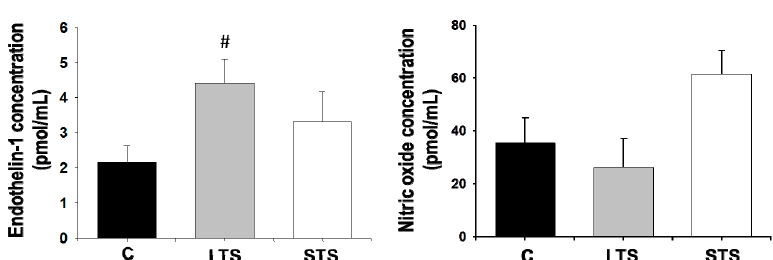
Figure 2. The effects of long-term (LTS) and short-term (STS) administration of sucrose on endothelin-1 and NO concentrations in plasma. Data represent mean ± SEM, # p < 0.05 after one-way ANOVA, n = 8 determinations from plasma from 8 different animals of each group.